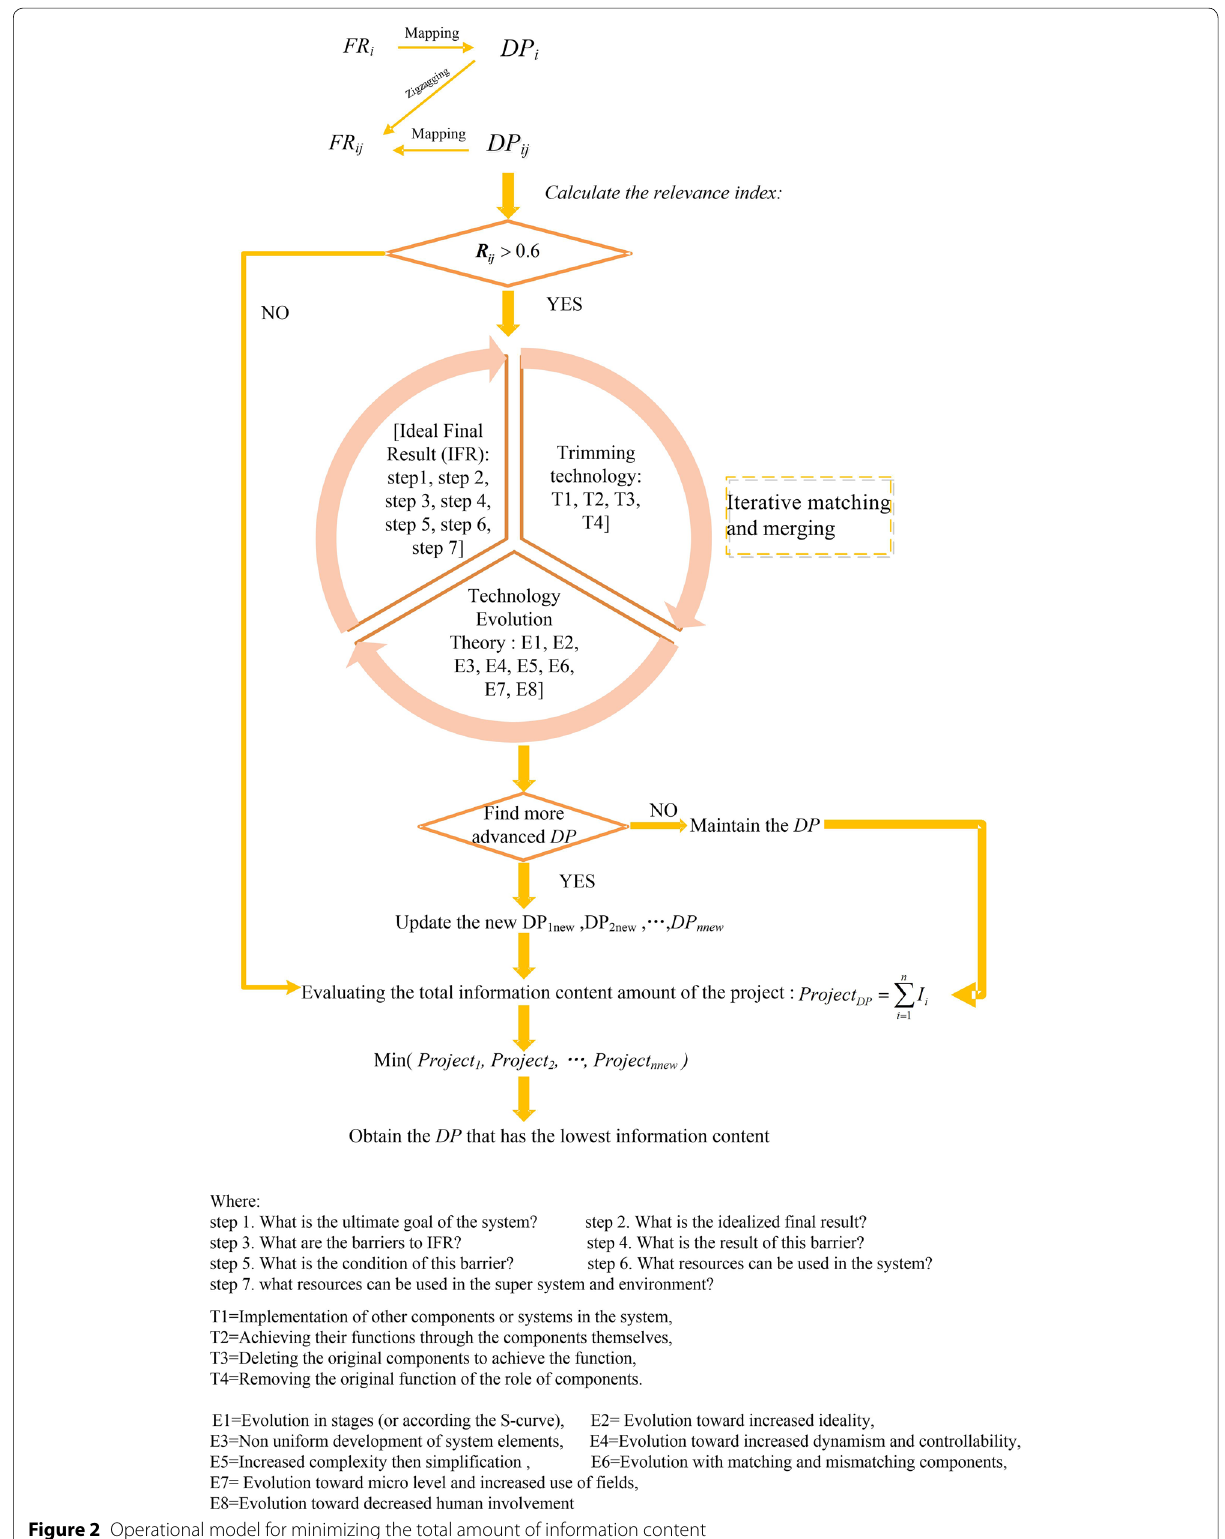
Figure 2 Operational model for minimizing the total amount of information